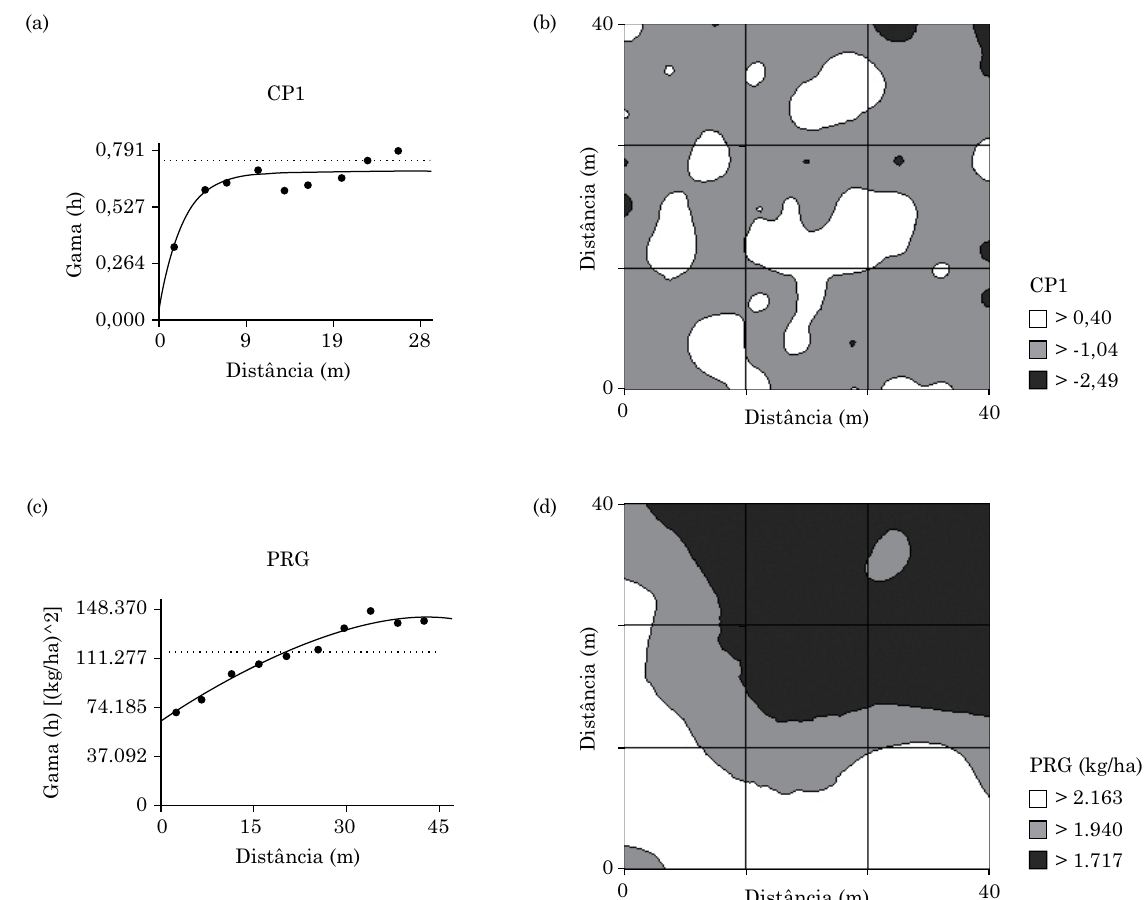
Figura 2. Semivariogramas e mapas de krigagem do componente principal 1 (CP1) e da produtividade de grãos de feijão